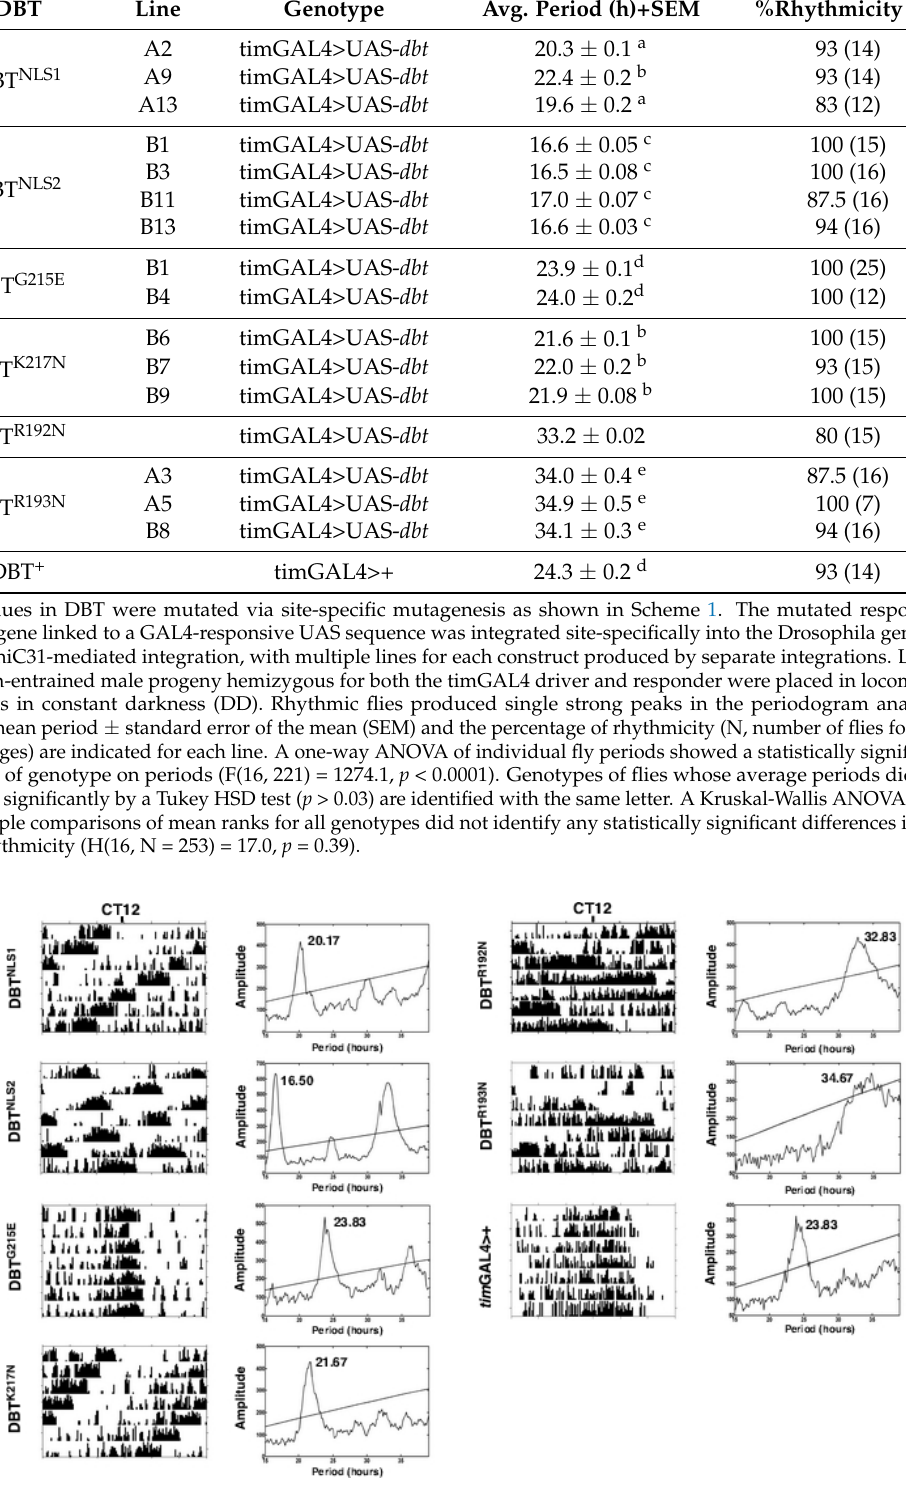
Figure 2. Representative circadian activity records. Males from lines with the indicated DBT transgene were crossed to timGAL4 virgins, and male progeny with the indicated genotypes (timGAL4/+> UAS- DBT/+ or timGAL4/+> +/+) were assayed for locomotor activity in constant darkness. The actograms and periodograms for a representative fly of each genotype are shown. CT12 indicates time of lights off in the previous 12 h:12 h LD cycle.